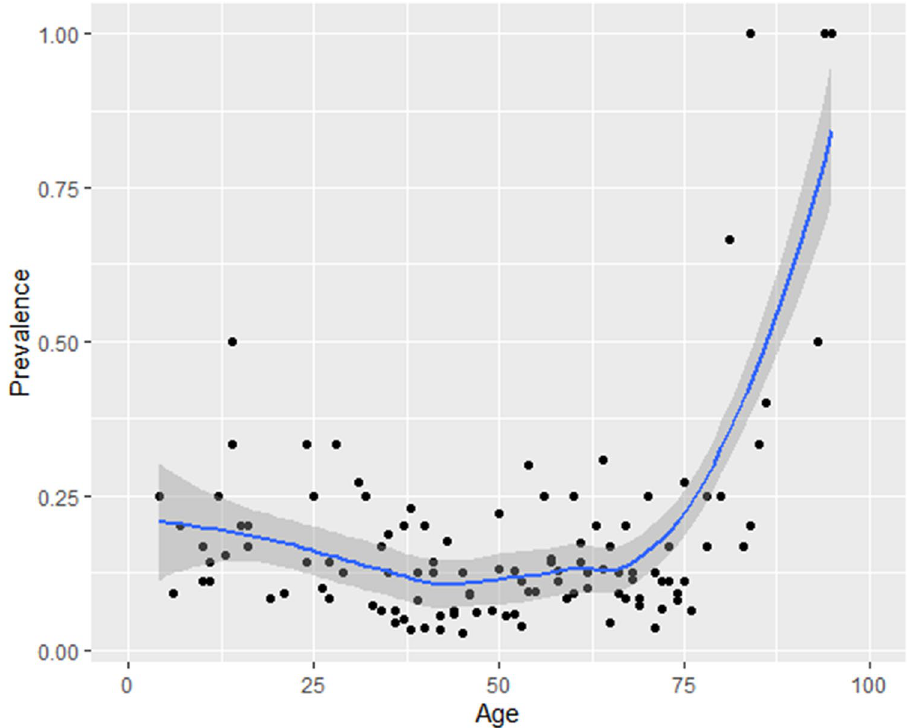
Figure 1. Relation between SARS-CoV-2 antibody seroprevalence and